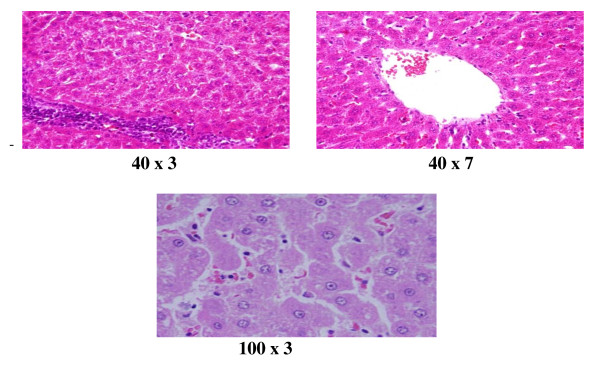
GNPs-treated rat received 50 μl of 10 nm particles for 3 days